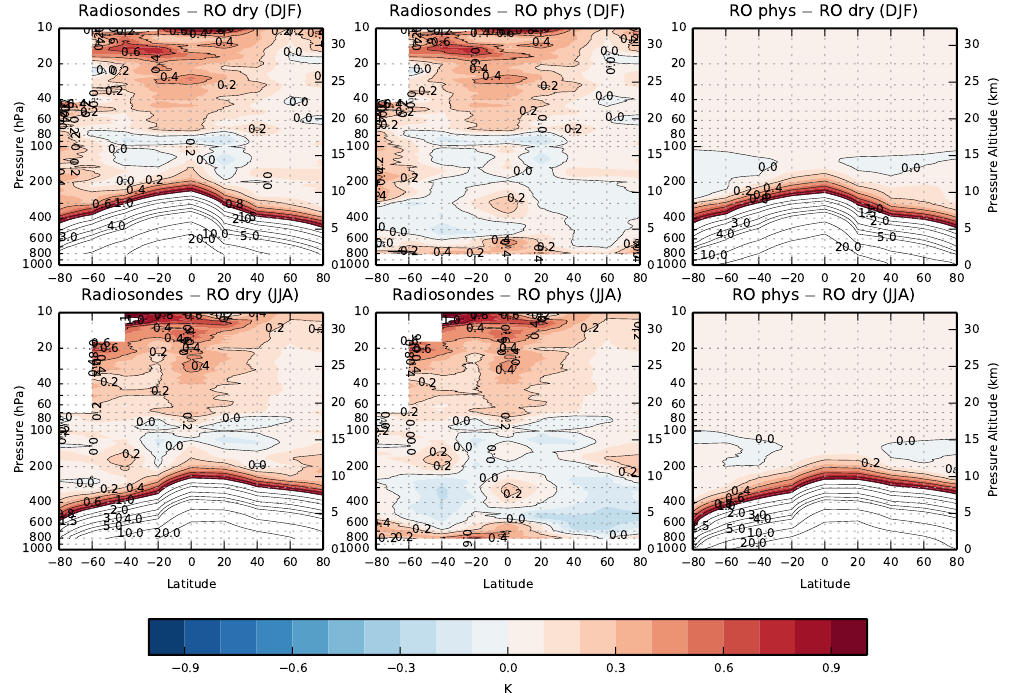
Figure 13. Dry (left) and physical (middle) seasonal mean temperature differences of RS versus GPSRO, and the difference of these two (right), for winter (DJF, top) and for summer (JJA, bottom) for the seven-years mean 2007 to